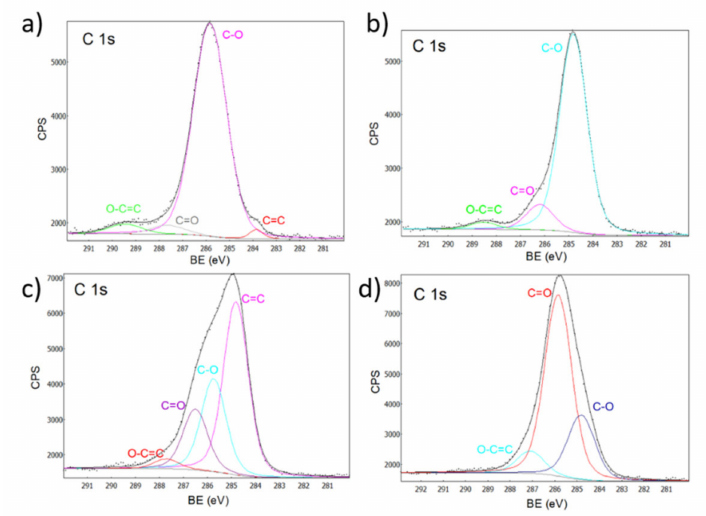
Figure 8. XPS spectra for carbon. ( a ) ZnO, ( b ) Zn-Ca 1, ( c ) Zn-Ca 3 and ( d ) Zn-Ca